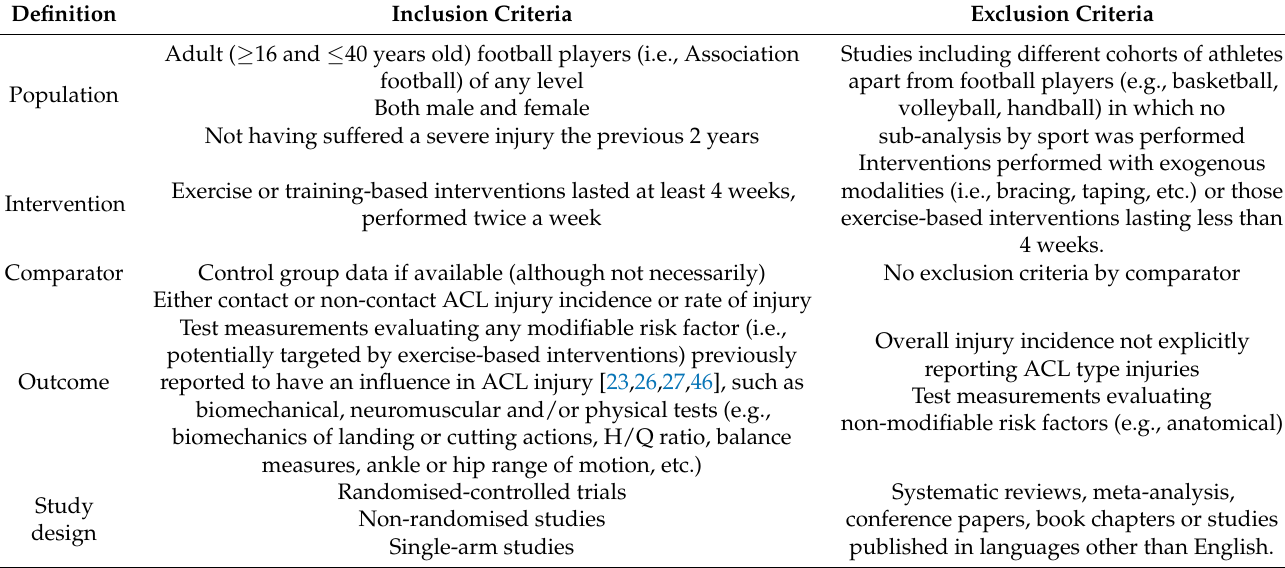
Table 1. Criteria for inclusion according to the PICOS